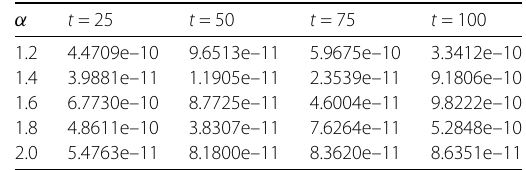
Table 4 Absolute mass errors of solutions to 3CNFSE (1) with initial conditions (22), using the ETDRK4-P13 scheme (13) ( N = 128, τ = 0.01)